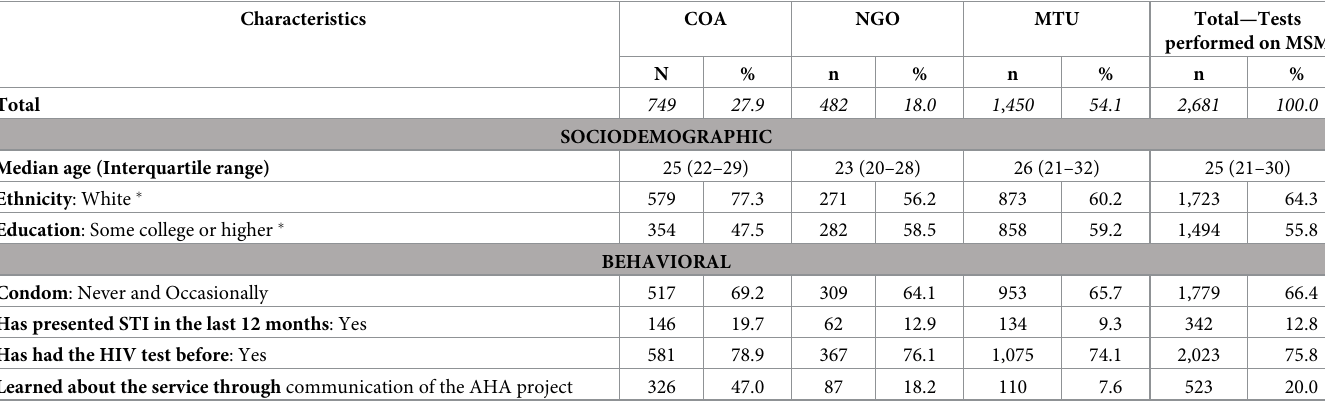
Table 3. Sociodemographic and behavior indicators of MSM according to the AHA´s strategies—Curitiba/PR/Brazil—03/01/2015 to 03/31/2017. Characteristics COA NGO MTU Total—Tests